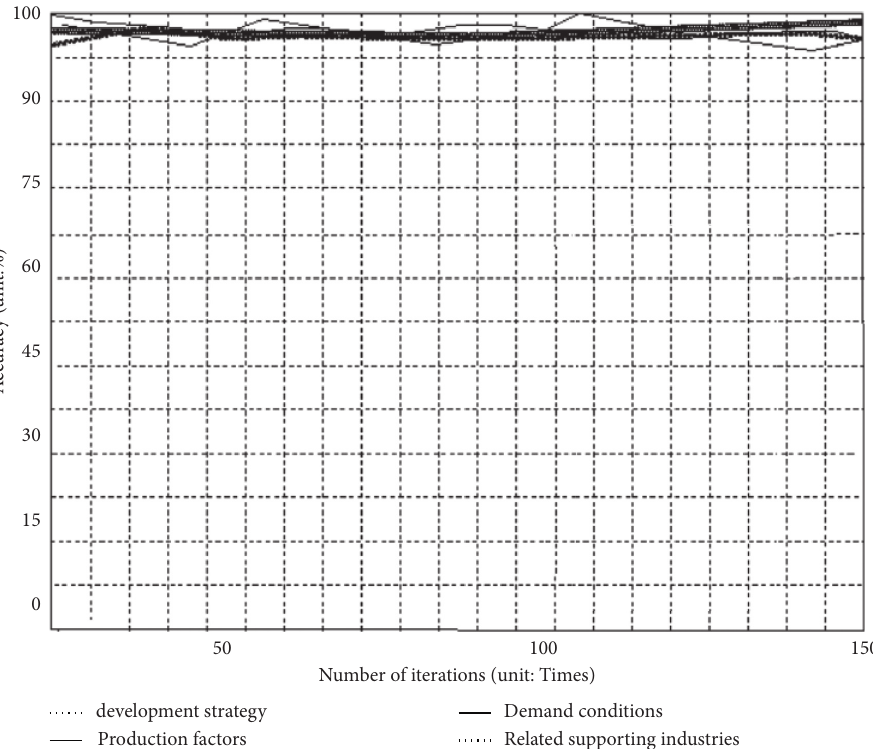
Figure 2: Accuracy of production factors, demand conditions, relevant supporting industries, and development